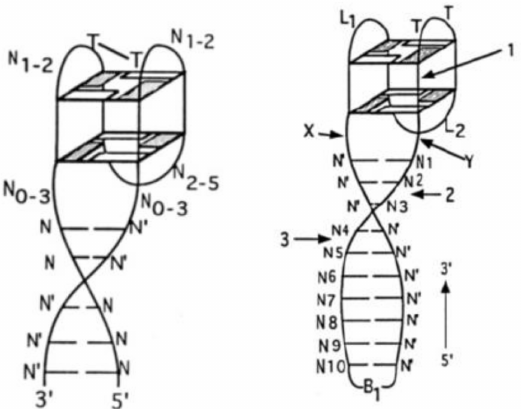
Figure 2. The presumed consensus structure of non-bridged ( left ) and bridged ( right ) quadruplex– duplex junctions selected by Macaya et al. [52], N—variable base position, N (cid:48) —base complementary to N, B 1 —triethylene glycol/disulfide bond, grey rectangles—guanosines in syn conformation. Reproduced with permission from ACS. Copyright © 1995, American Chemical